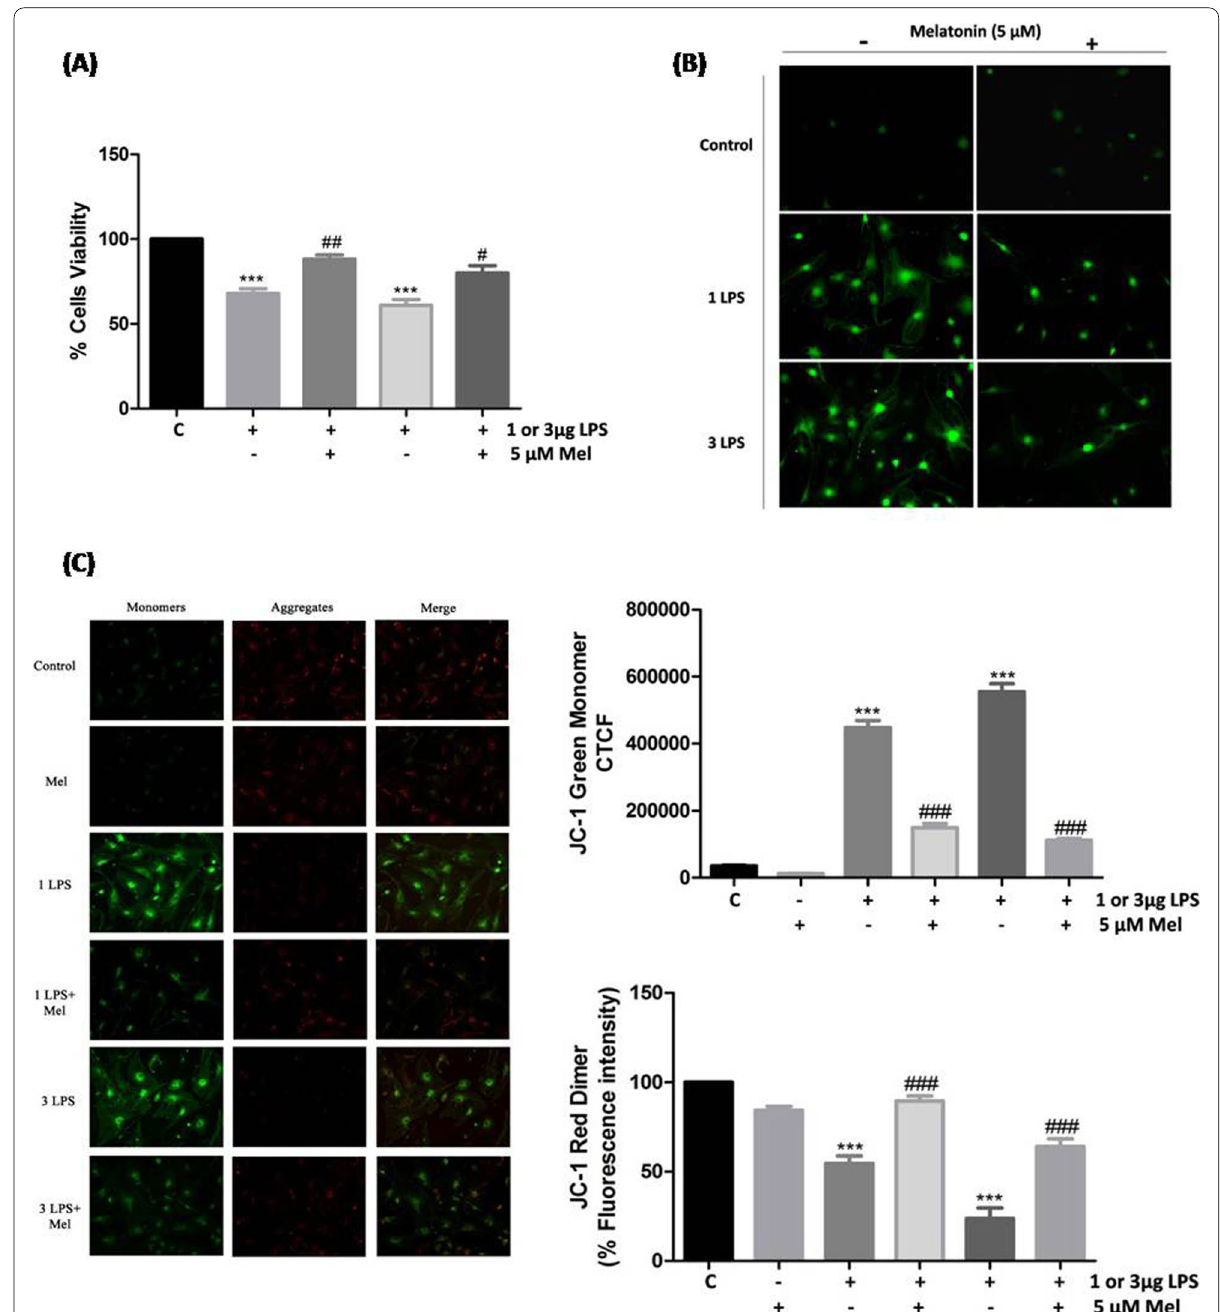
Fig. 1 Adipose-derived MSCs treated with lipopolysaccharide (LPS) and/or melatonin (Mel). Mel alleviates LPS-induced ( A ) cytotoxicity; MTT assay, ( B ) intracellular oxidative stress; DCFDA staining and ( C ) mitochondrial membrane potential; JC-1 staining. Data expressed as